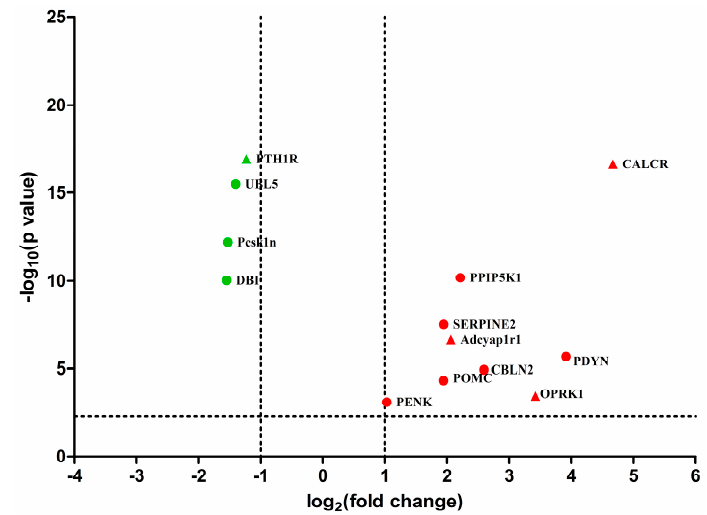
Figure 3. Volcano plot displaying differential expressed neuropeptide and neuropeptide receptor genes between EA and the control group. The y -axis corresponds to the value of log 10 ( p value), and the x -axis displays the log 2 (fold change). The red dots represent the up-regulated neuropeptides genes ( p < 0.005). The green dots represent the down-regulated neuropeptides genes ( p < 0.005). The red triangles represent the up-regulated neuropeptide receptor genes ( p < 0.005). The green triangles represent the down-regulated neuropeptide receptor genes ( p < 0.005).